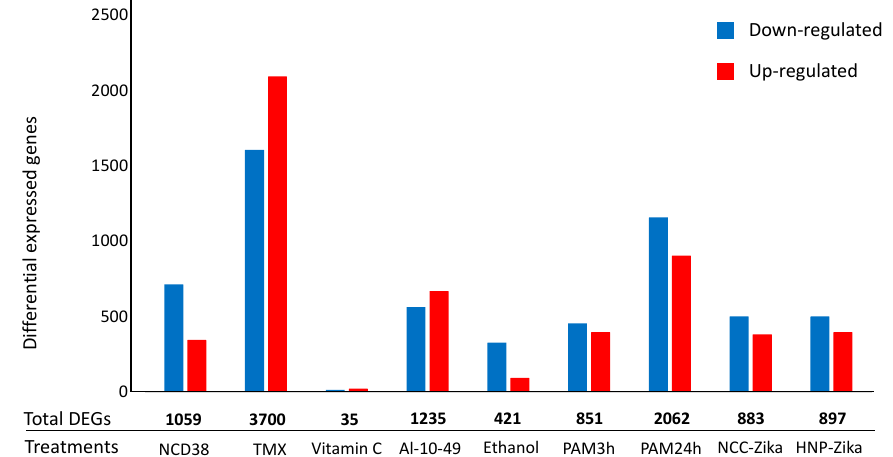
Figure 2. Number of differential expressed genes (DEGs) in H. sapiens cell-death-related RNA-seq experiments. The histogram represents the number of up-regulated (red) and down-regulated (blue) DEGs for each experiment. Numbers in bold represent the total number of DEGs per experiments.